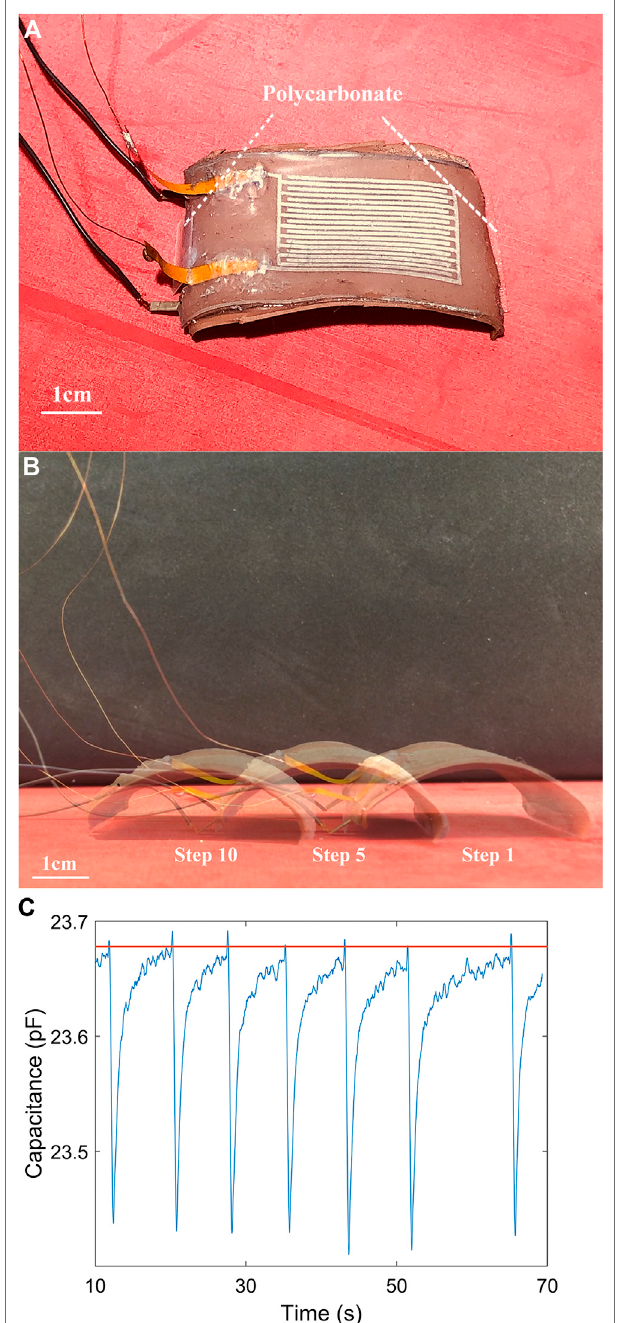
FIGURE 10 | (A) A single actuator with two small pieces of polycarbonate attached at both edges. (B) Composite of video frames showing the single actuator with auxilary components traveling over 150 s. The curvature is almost the same in three relaxed states. (C) The capacitance measurement during a 60-second period of locomotion. The orangestraightlineistheassignedthreshold(23.68 pF)inthecontrolstrategy.